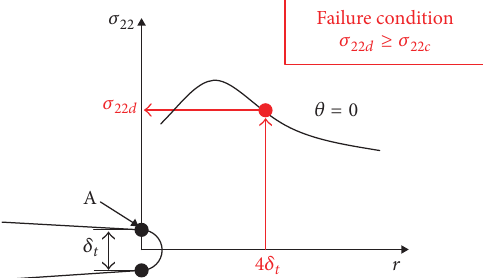
Figure 1: (4𝛿 𝑡 , 𝜎 22𝑐 ) failure criterion, which predicts the onset of cleavage fracture when the crack-opening stress 𝜎 22 , measured at a distancefrom thecrack-tip equal tofourtimes thecrack-tip opening displacement (CTOD) 𝛿 𝑡 (hereinafter denoted as 𝜎 22𝑑 ), exceeds a critical value 𝜎 22𝑐 [3,